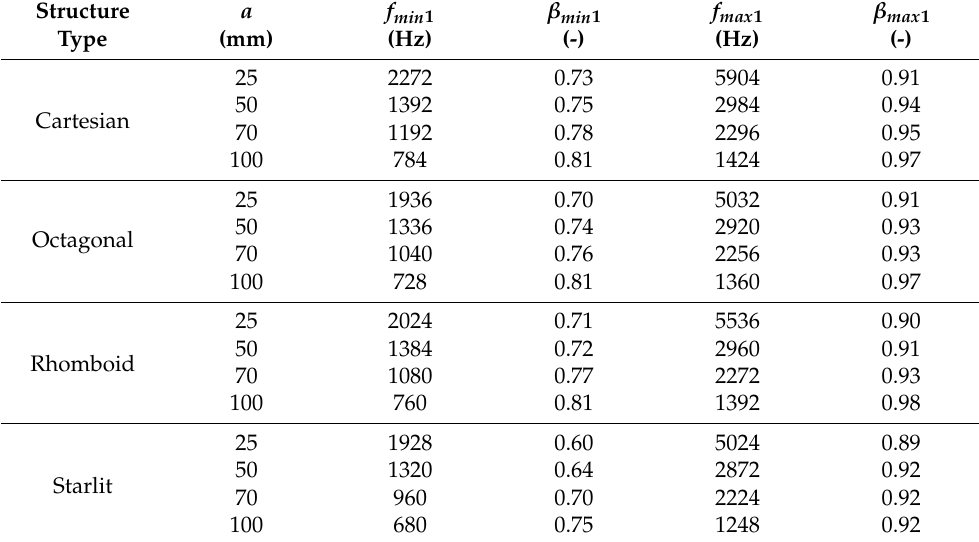
Table 2. Primary sound reflection minima and maxima and their corresponding excitation frequencies depending on the air gap size for the studied 3D-printed open-porous PLA material structures of thickness t = 10 mm and porosity P = 56%.